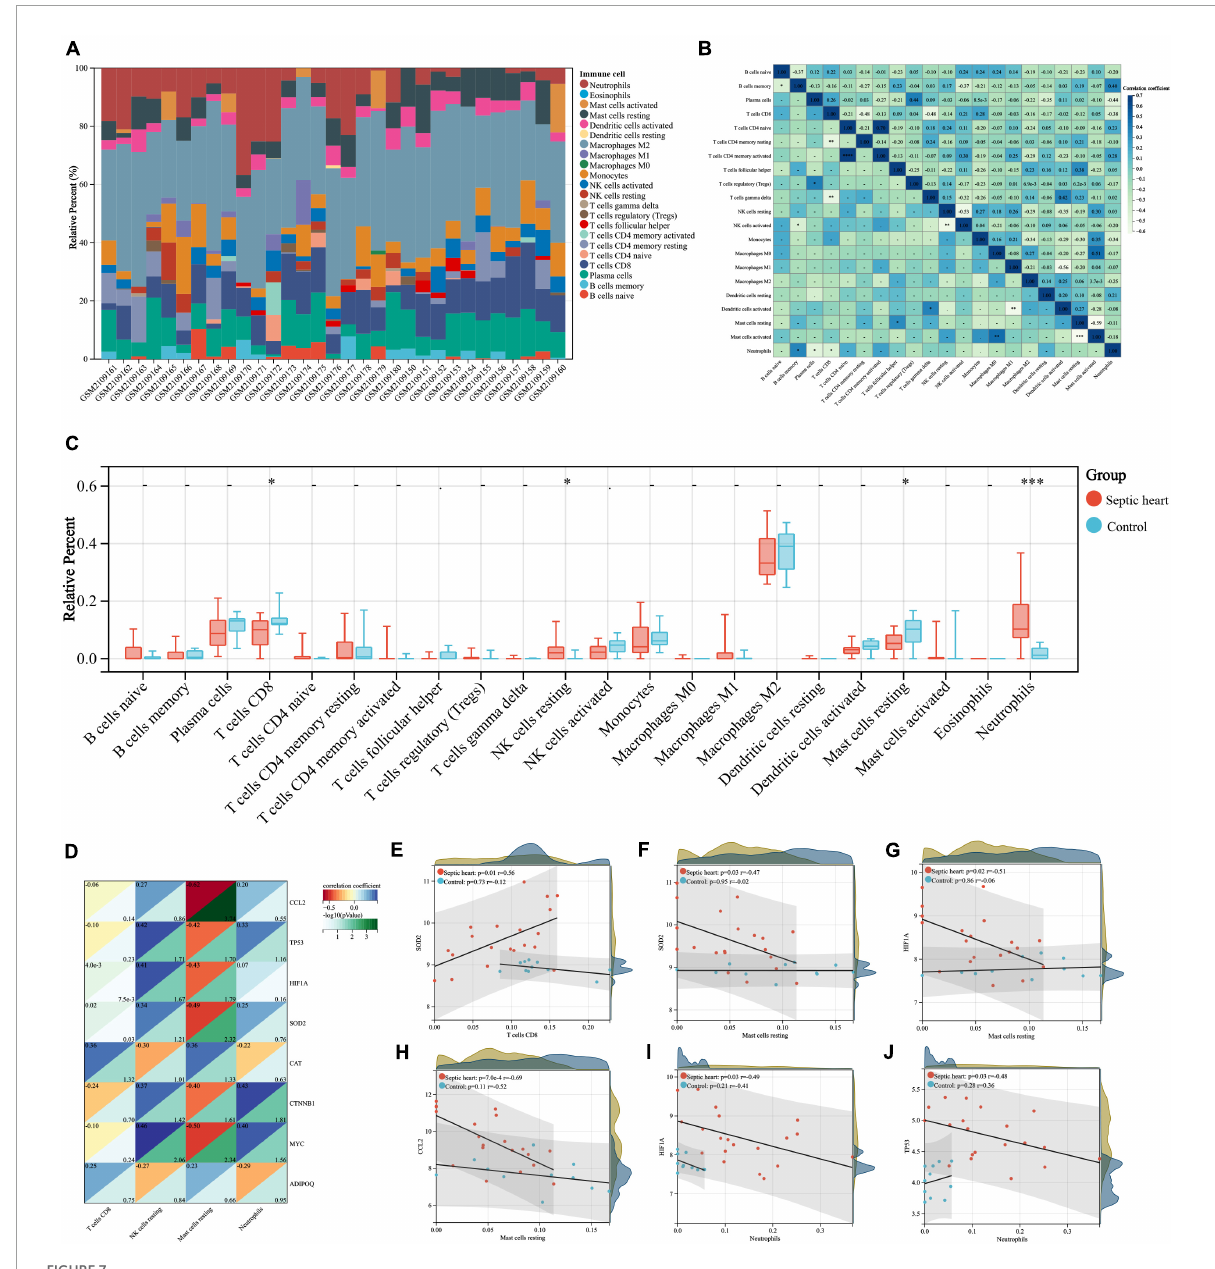
FIGURE7 (A) Correlation analyses between key genes and DIICs. The proportion of infiltrating immune cells of the samples from GSE79962 by the CIBERSORT algorithm. (B) Correlation heatmap of DIICs in GSE79962, correlation coefficients are plotted with negative correlation (green) and positive correlation (blue). (C) Comparison of infiltrating immune cells between septic and normal hearts in GSE79962. (D) Correlation heatmap of DIICs and key genes in GSE79962, correlation coefficients are plotted with negative correlation (red) and positive correlation (blue), while p values are negatively correlated with greenness. (E–J) Linear regression plots presenting the significant correlation between key genes and DIICs. DIIC, differentially infiltrating immune cell. ∗ p < 0.05, ∗∗ p < 0.01, ∗∗∗ p < 0.001, ns = not